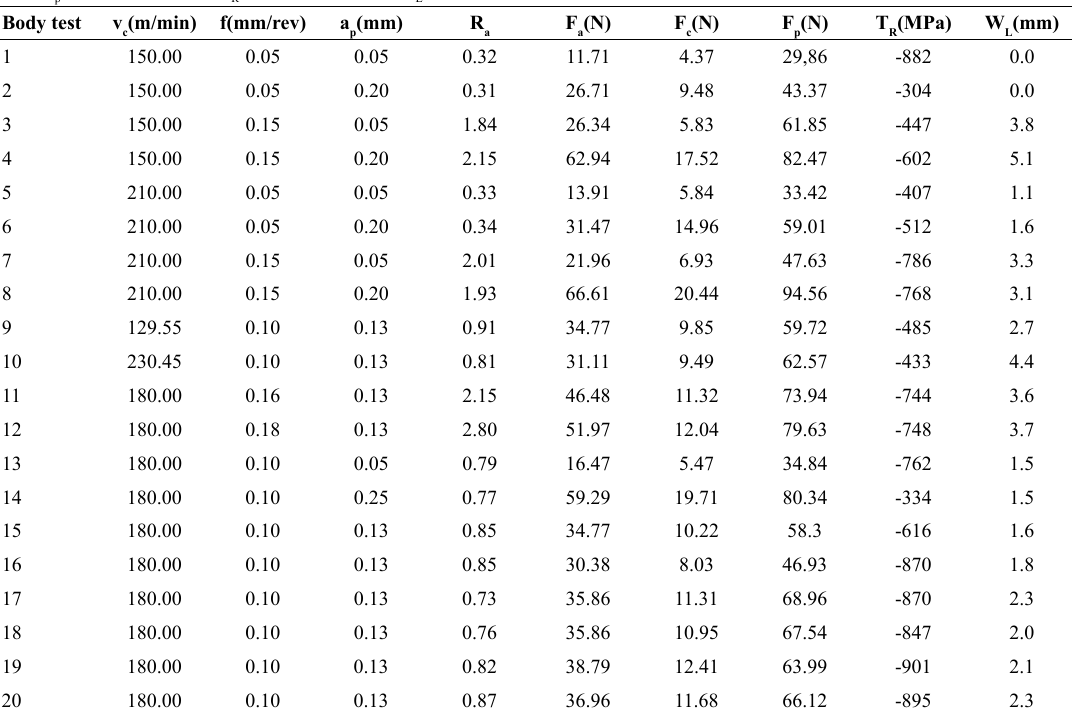
=cutting speed; f=feed rate; a c =White layer thickness) L